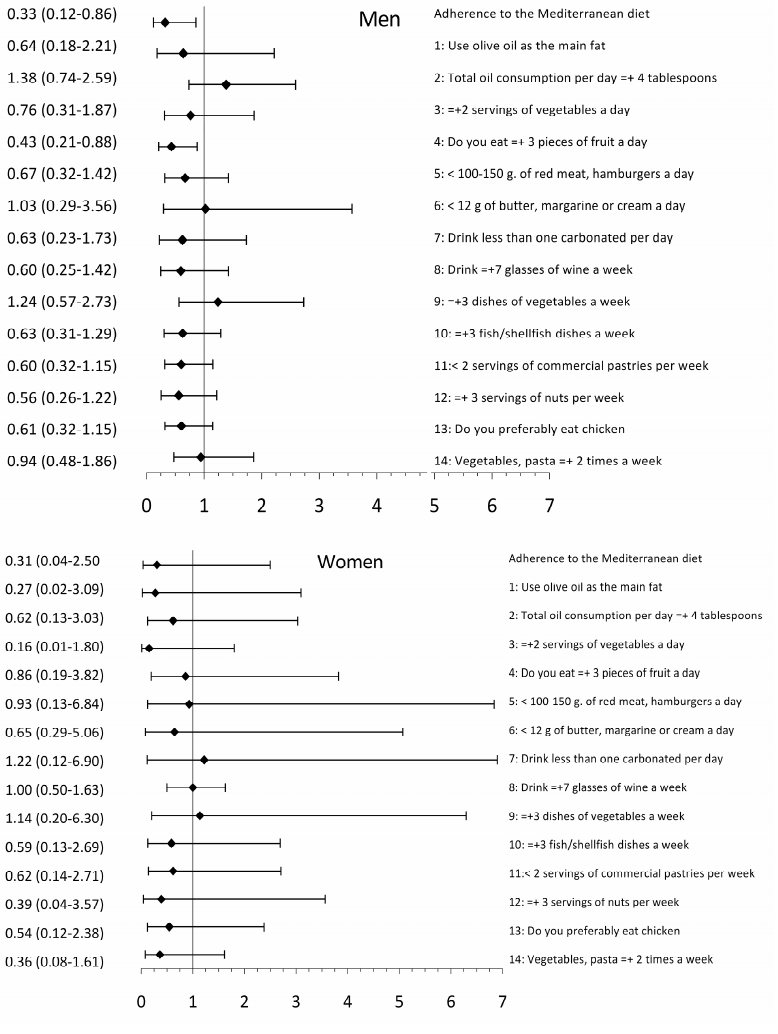
Figure 3. Bars show OR, (odds ratio), and 95% CI. Association between arterial aging and adherence to the Mediterranean diet and its components by sex. Dependent variable: the presence of early vascular aging (EVA) versus normal vascular aging (NVA) (1 = EVA, 0 = NVA). Independent variables: adherence to the Mediterranean diet) and each of its components (1 = Yes, 0 = No).1, For cooking,